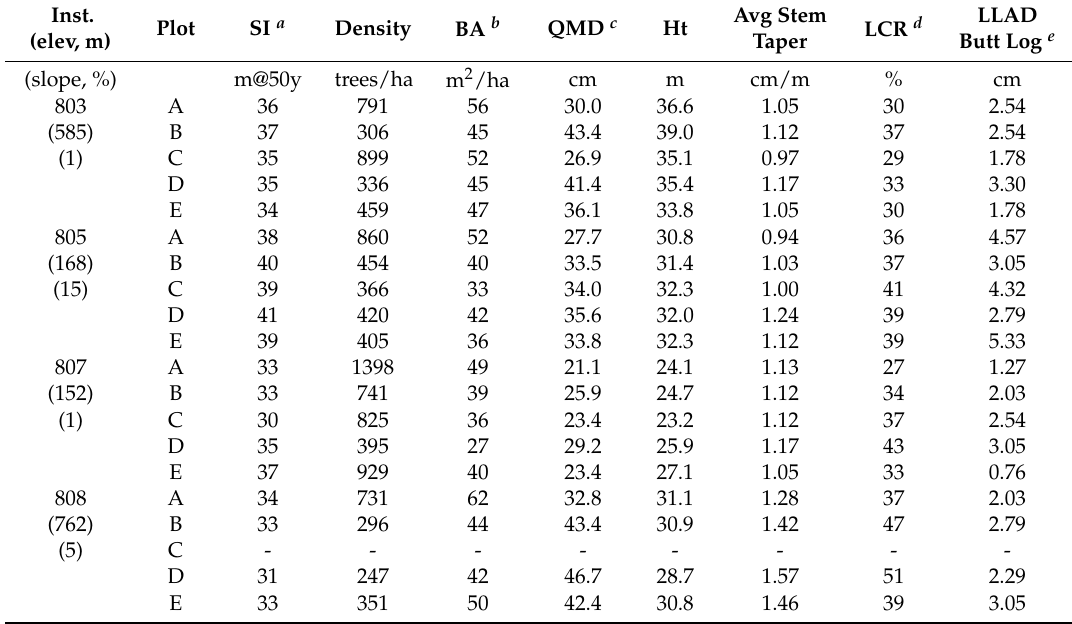
Table 2. The delayed thinning plot (C) of installation 808 was lost due to a windstorm, so no data were available for this treatment from that site. Table 2. Selected site, stand and tree characteristics for the four installations by plot.